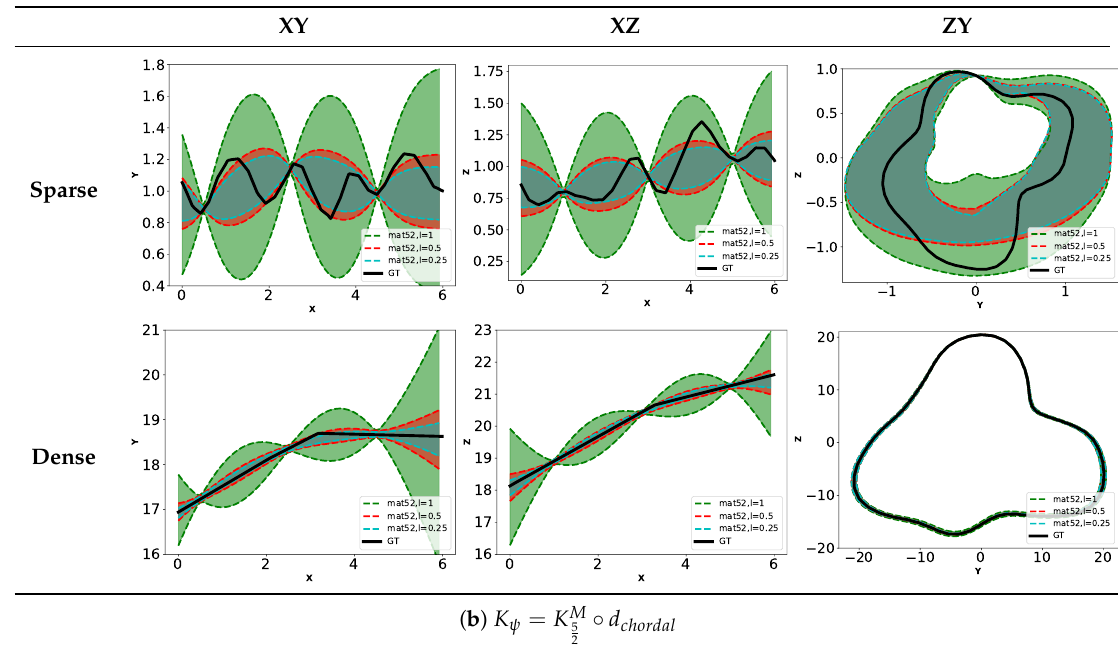
Figure 14. Contours of estimated surface with fixed K s = K M